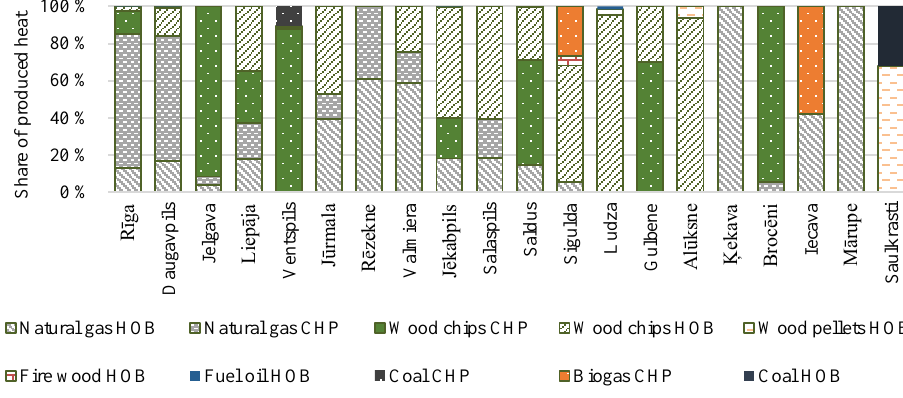
Fig. 4. Heat production technologies and energy sources used in analysed DH systems.